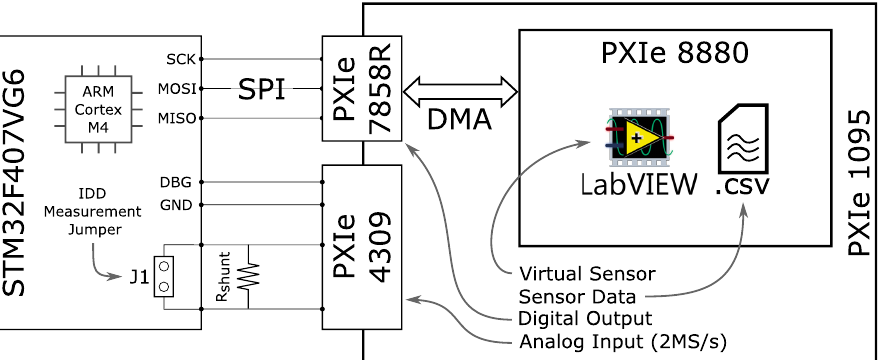
Figure 8. Architecture of the hardware-in-the-loop test system. The PXI system comprises a PXIe-4309 Analog Input module to monitor current consumption in each stage of the pipeline. The PXIe7858R FPGA, along with the PXIe-8880 Windows 7 controller, implements the Virtual Sensor and allow loading MEMS readings from a CSV file in real-time, emulating a real buffered digital MEMS node in hardware. The whole application runs on a STM32F4 development board featuring a Cortex-M4 ARM